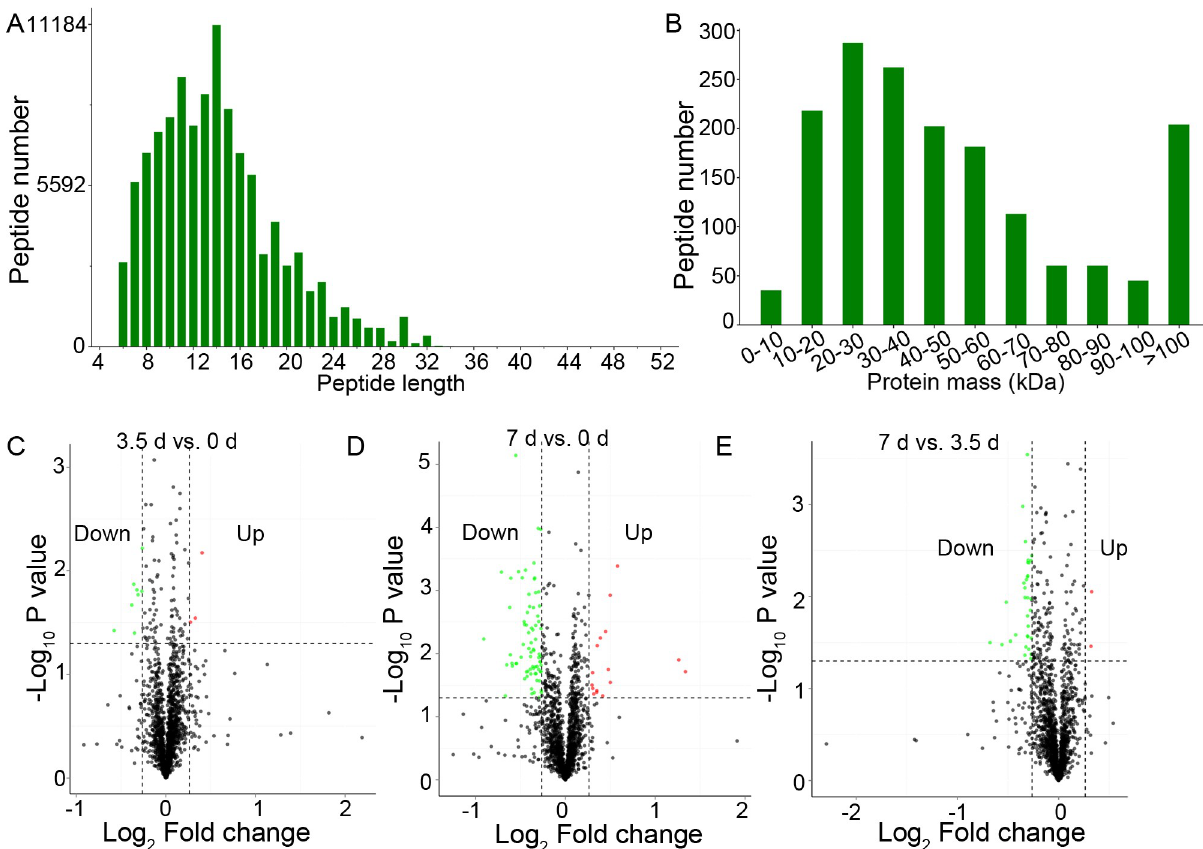
Fig 2. Summary of peptides and proteins, and the Differentially Expressed Proteins (DEPs). (A), the length of the peptides. (B), the mass of the peptides. (C-E), the Volcano plot of the DEPs in beef muscles between 3.5 d and 0 d, 7 d and 0 d, and 7 d and 3.5 d, respectively.